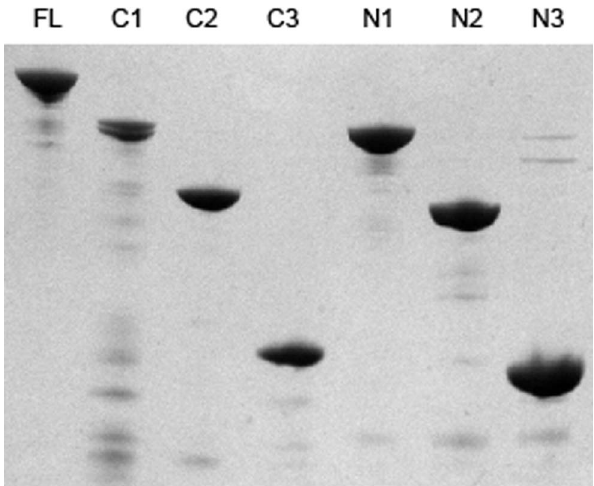
Figure 3. SDS-PAGE analysis of purified truncated derivatives of PhtD. Truncated derivatives of PhtD were analysed by SDS-PAGE using a 12% acrylamide gel and subsequently stained using Coomassie R250. 1 m g of each protein was used. The identity of the protein is indicated above each lane (FL; full length).